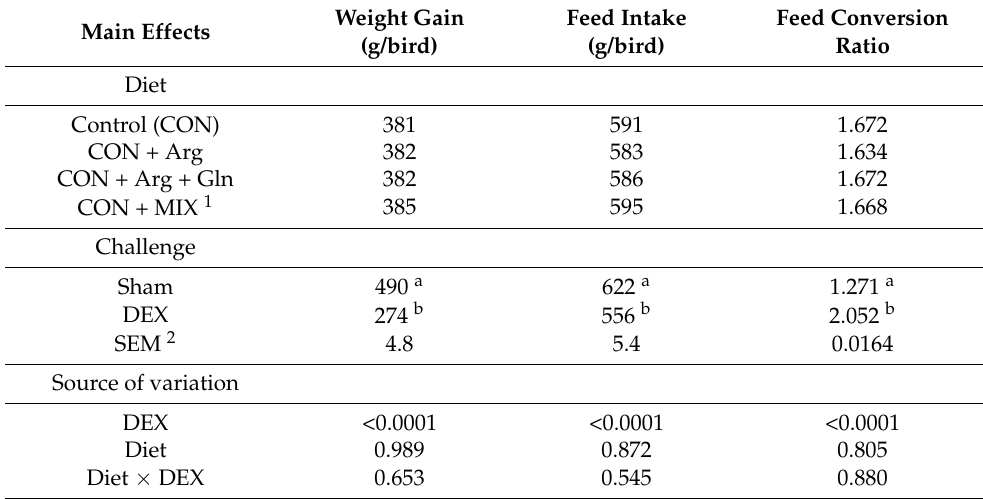
Table 5. Indicative 1-week (day 14 to 21 of age) performance of individually housed birds subjected to dexamethasone (DEX) or sham injections (experiment 2).